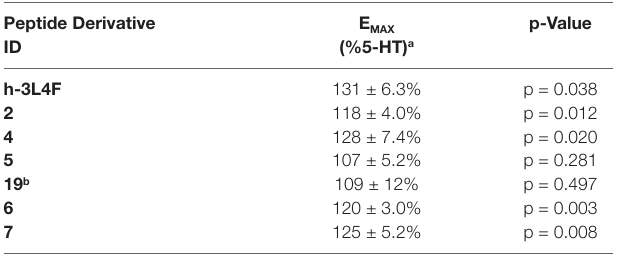
TABLE 1 | Effects of h3L4F and peptide 2 derivatives (1 nM) on 5-HT-induced